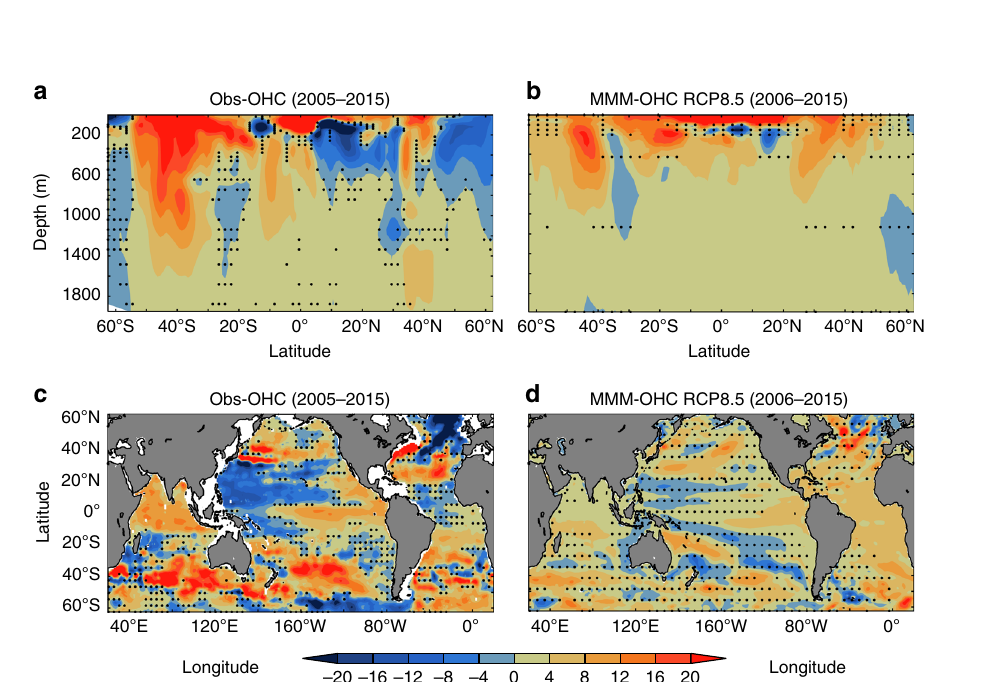
Fig. 2 Linear temporal trend in ocean heat content anomaly. a Observed Linear trend for 2005 – 2015 of zonally integrated global ocean heat content anomaly (10 11 J m − 2 year − 1 ). b Same as ( a ) but for MMM trend for 2006 – 2015, c observed linear trend of global ocean heat content anomaly for 0 – 2000 m (10 7 J m − 2 year − 1 ) for 2005 – 2015, d Same as ( c ) but for MMM trend for 2006 – 2015. Stippling indicates the locations where OHC anomaly trends are not signi fi cant, i.e., <2*standard error of the trends estimated from ( n = 6) observation products and ( n = 11) CMIP5 models used in this